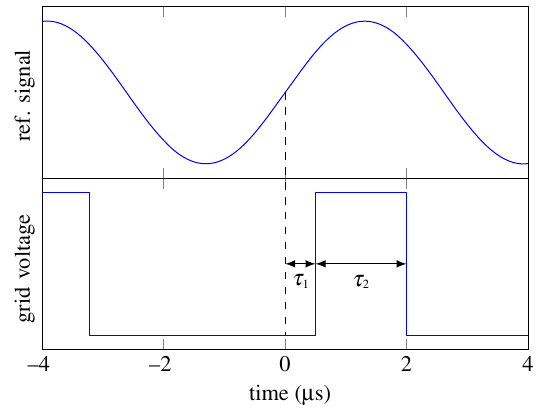
FIG. 2. Schematic model of the electron pulse synchronization